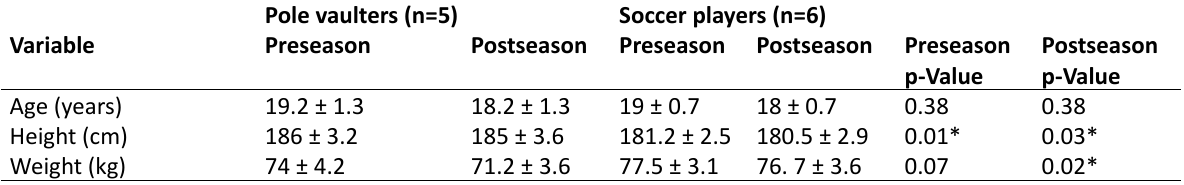
Table 1. Demographics of the athletes